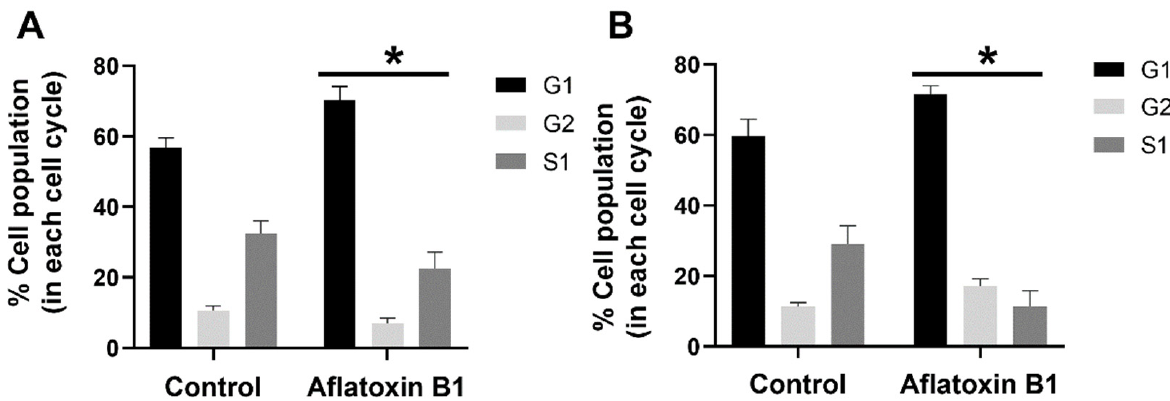
Figure 5. Percentage of MCF7 ( A ) and MCF10A ( B ) cells at different stages of the cell cycle after treatment with aflatoxin B1. * p < 0.05 as compared to control.